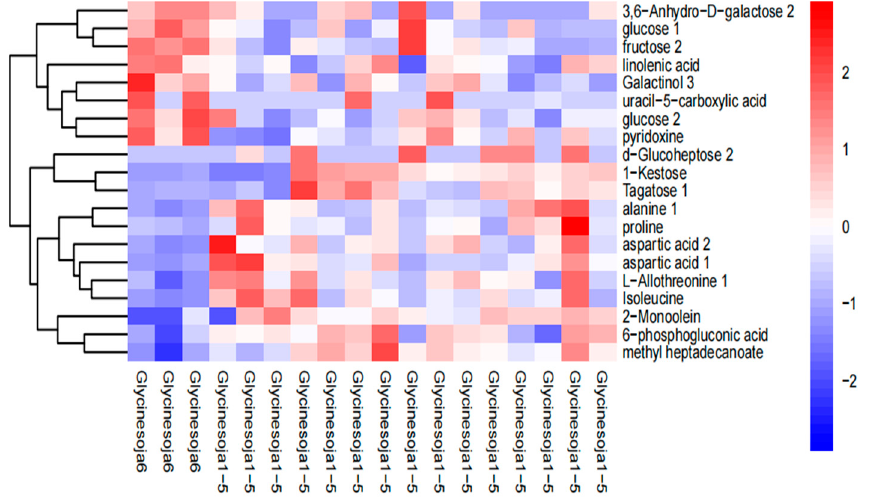
Figure 4. Hierarchical cluster heatmap of the metabolites.